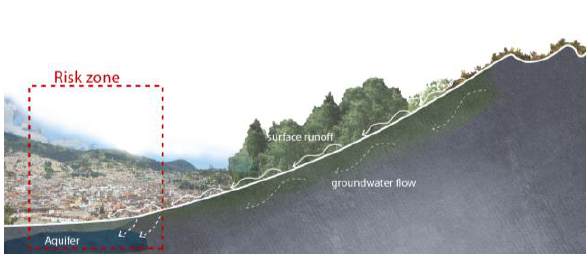
Figure 6. Pichincha slope water system facing with the